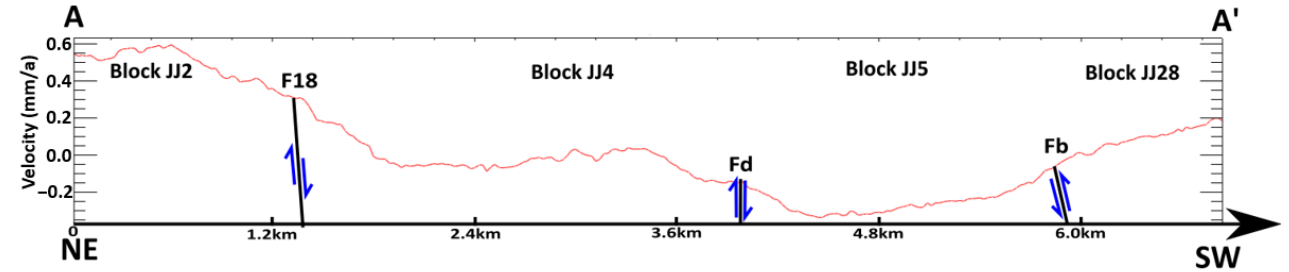
Figure 10. Vertical displacement along cross-section AA’ shown in Figure 6. This cross-section is formed from 300 PS displacement values sampled along the cross-section line and shows the annual relative movements within each fault block. The marked faults are interpreted from the PS displacement maps and they are illustrative, showing the sense of fault movement and general direction of faults.